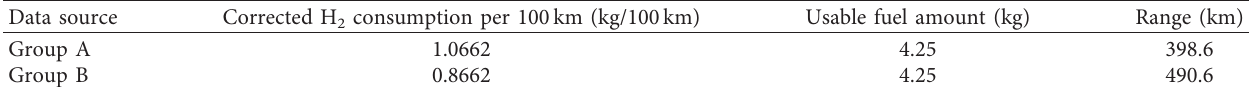
Figure 4: The linear fitting results of H 2 consumption for samples A and B. Table 1: H 2 consumption corrected results and calculated